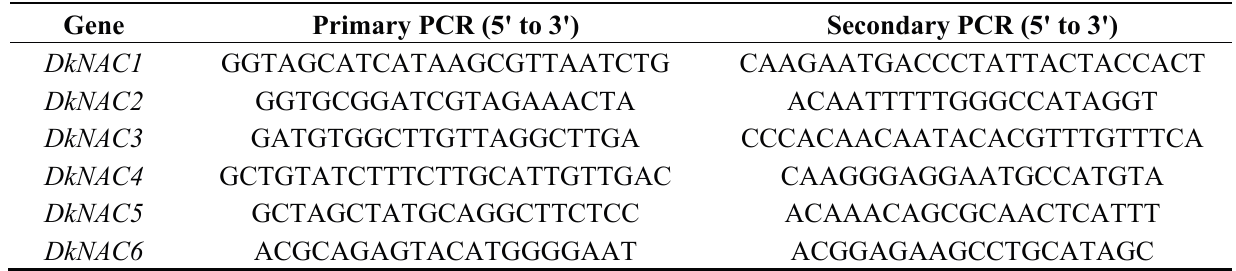
Table 2. Sequences of the primers used for real-time